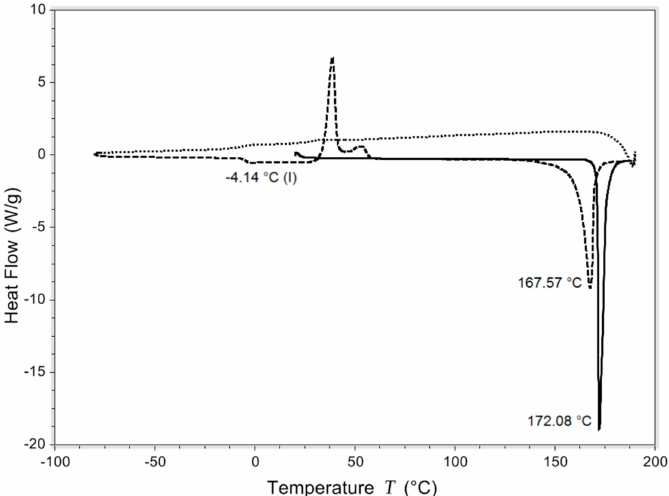
Figure 2. Di ff erential scanning calorimetry (DSC) curve of one of the heat / quench cool / heat experiments. The solid line is the first heating, the short dashed line is quench cooling, and the long dashed line second heating. Exo is